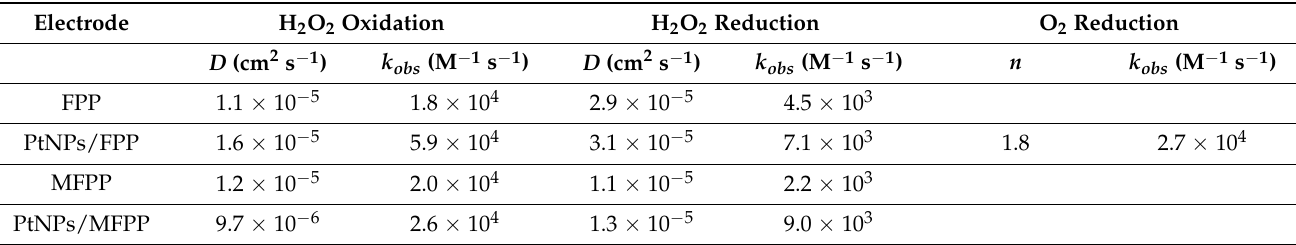
Table 2 summarizes the average results of at least five electrodes with coverages within the optimal range. Table 2. Results of the kinetic studies of hydrogen peroxide and oxygen catalysis.